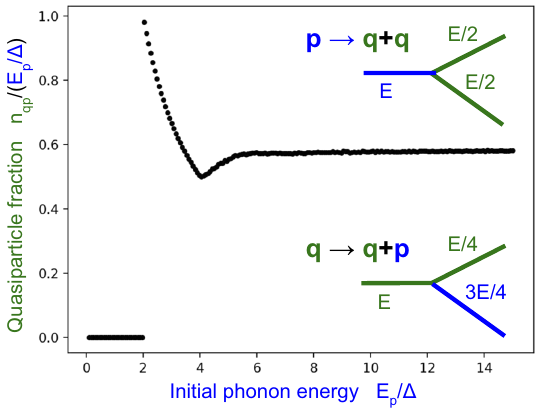
Fig. 4 Phonon to quasiparticle down-conversion ef fi ciency. Plot of normalized number of quasiparticles versus initial phonon energy, solved via numerical simulation for the random energy branching of the scattering processes p → q + q and q → q + p. No quasiparticles are generated for E p < 2 Δ , and 2 for 2 Δ < E p < 4 Δ , as expected. At high energies, 57% of the initial phonon energy is converted to quasiparticles on average. The insets depict the scattering process, listing the average kinetic energies.